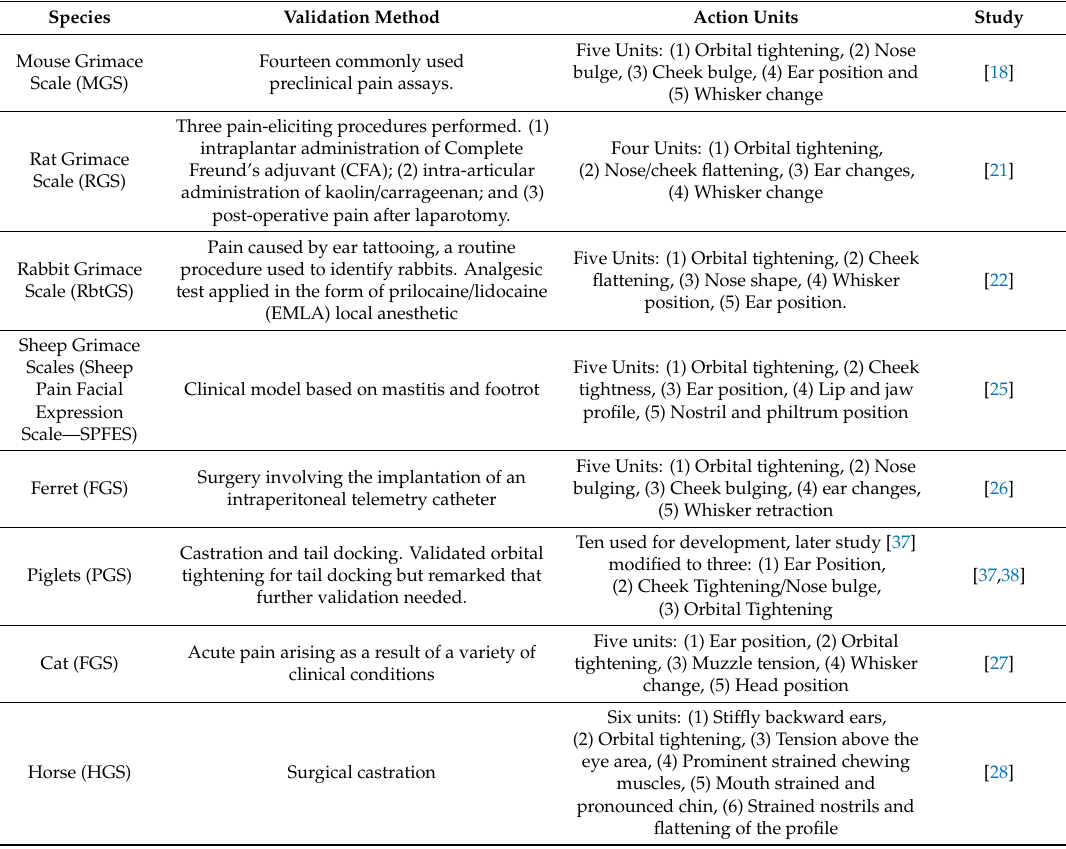
Table 1. Original studies in which grimace scales were developed for a range of species commonly used as laboratory animals. Species Validation Method Action Units Study Mouse Grimace Fourteen commonly used Scale (MGS) preclinical pain